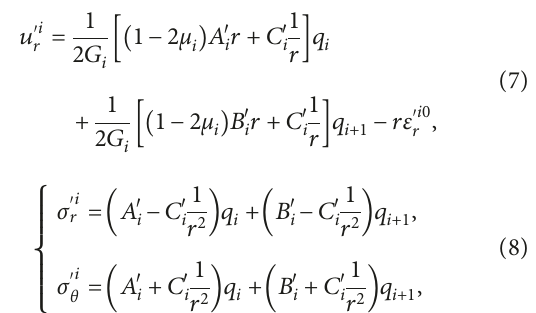
i ; thermal stress, σ T